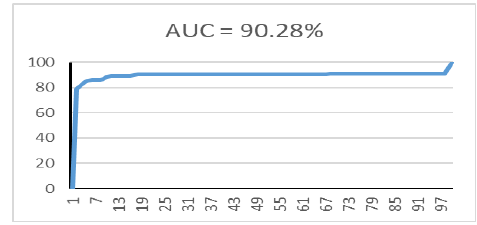
Figure 12. Validation result of the ANN analysis